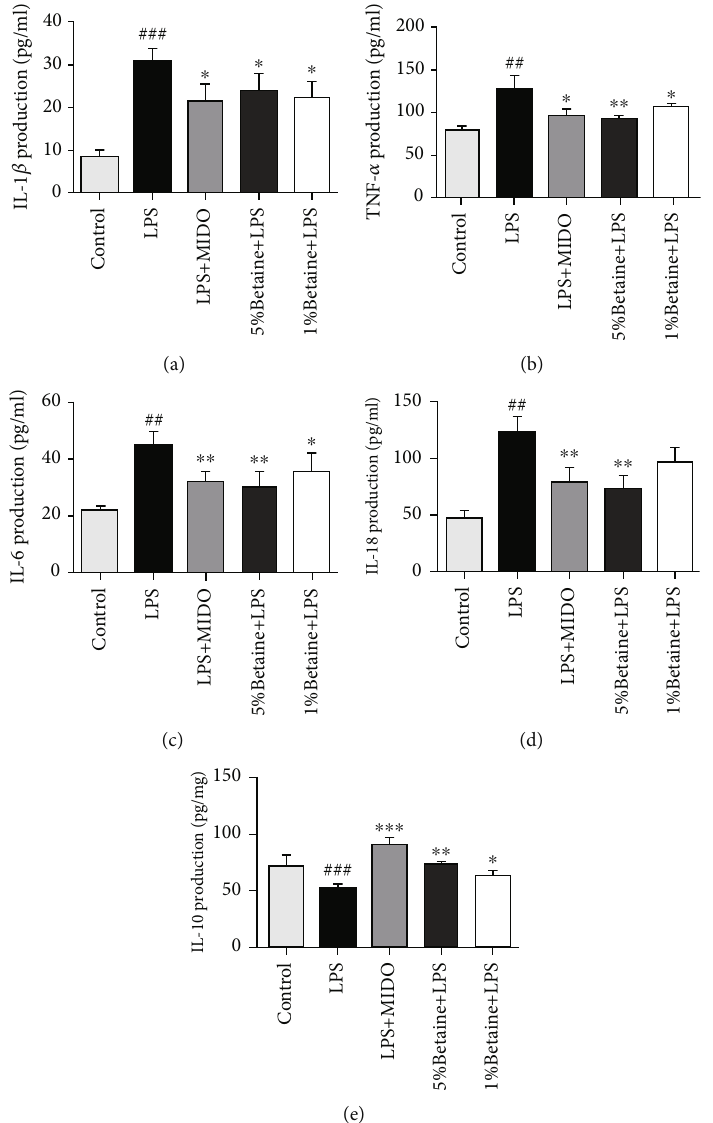
Figure 4: E ff ects of betaine on LPS-induced in fl ammatory cytokine production in mice hippocampus. (a – e) The expression levels of IL-1 β , IL-6, IL18, TNF- α , and IL-10 in mouse hippocampus were determined by ELISA, with minocycline as the positive control. The results were expressed as mean ± SEM ; ## P < 0 : 01 and ### P < 0 : 001 compared to the normal control group; ∗ P < 0 : 05 and ∗∗ P < 0 : 01 compared to the model group, n = 4